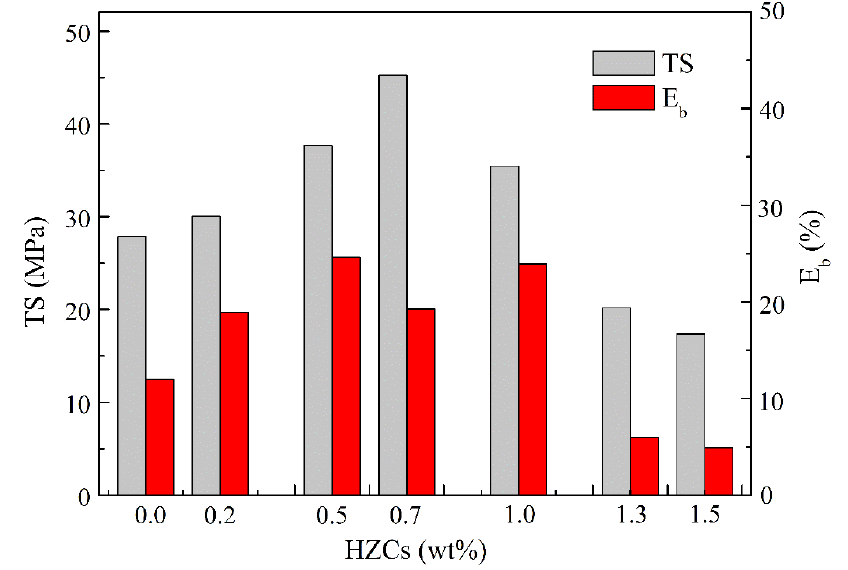
Figure 6. Mechanical strength of the nanocomposite membranes.